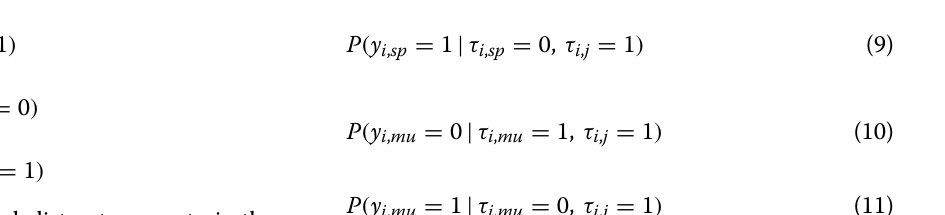
FN i , sp ≡ ( y i , sp = 0, τ i , sp = 1 ) FP i , mu ≡ ( y i , mu = 1, τ i , mu = 0 )